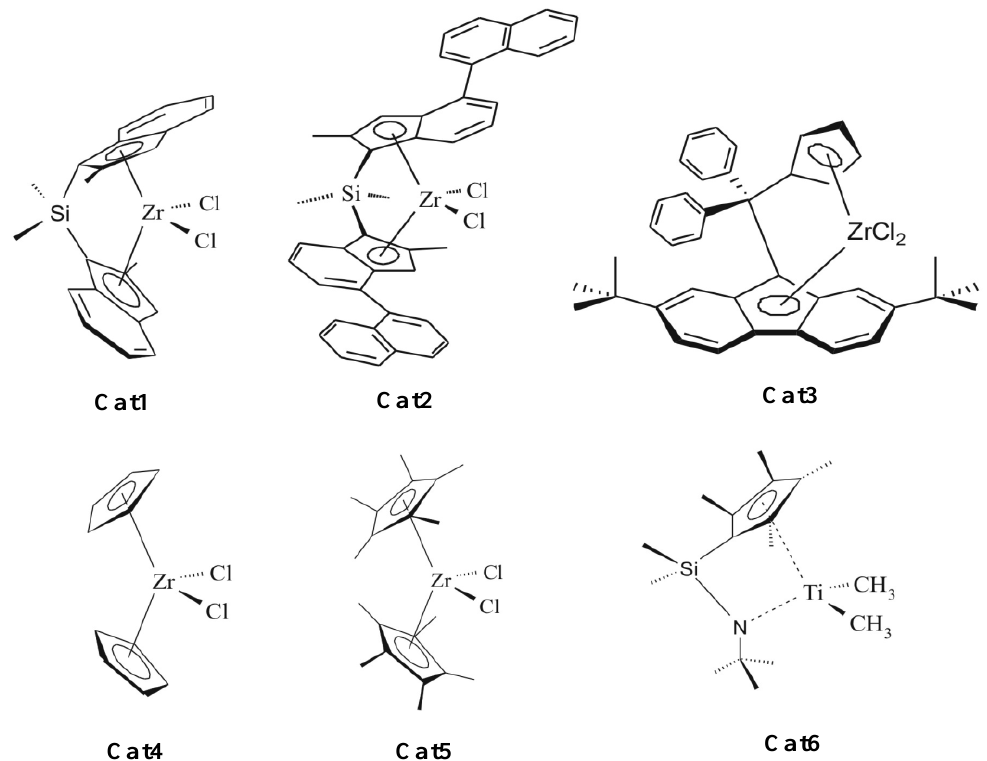
Figure 3. Structures of metallocenes used for the synthesis of polypropylene and